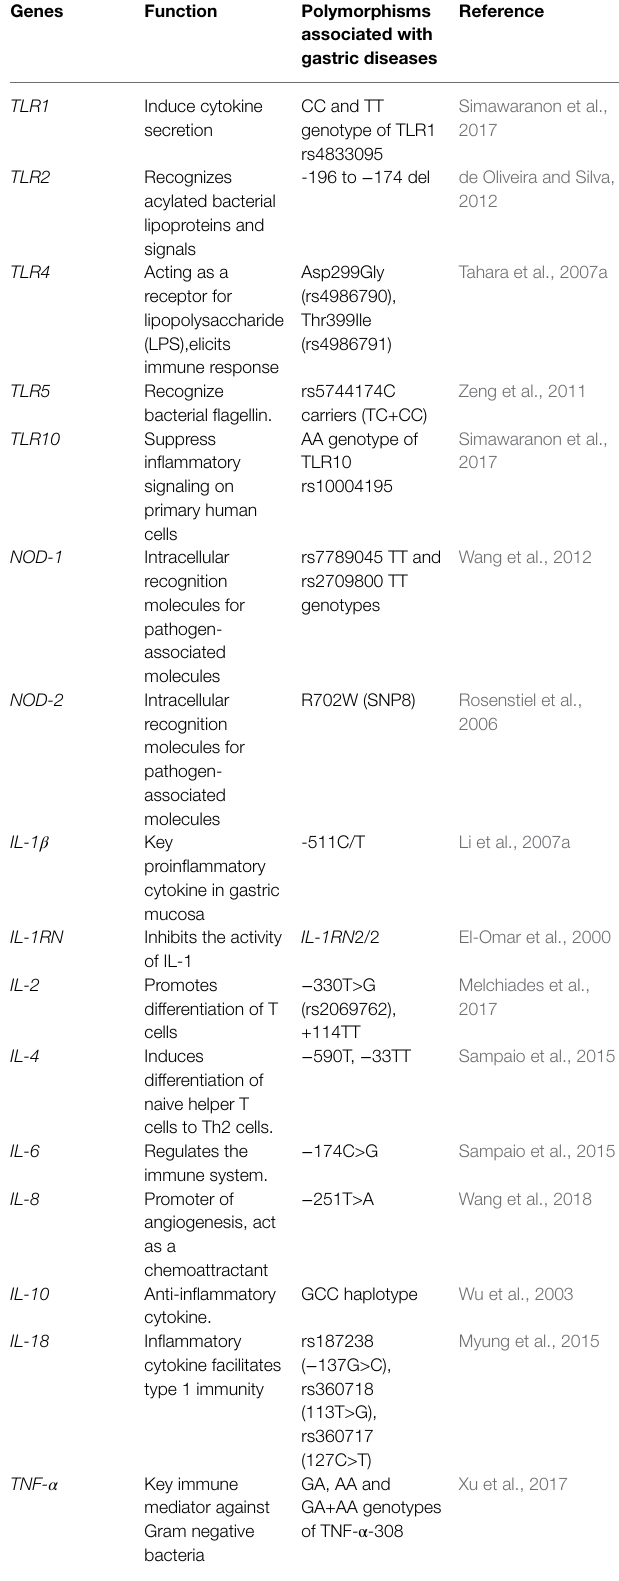
TABLE 3 | Human genes mediating immune response and their polymorphisms associated with risk of gastric diseases.